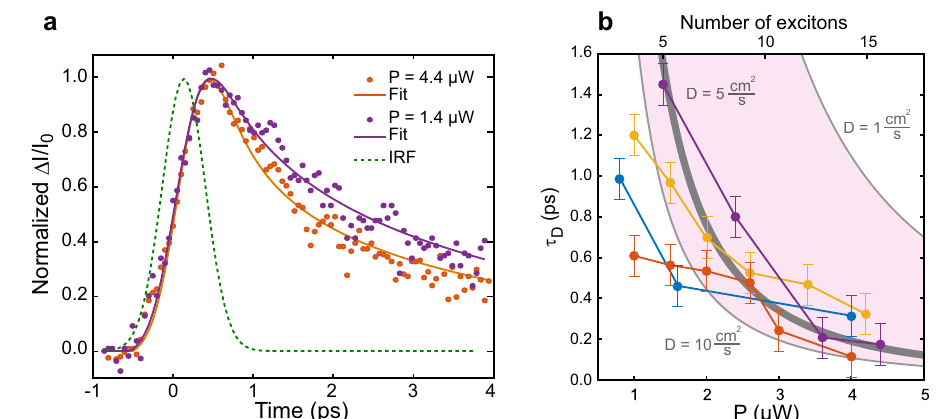
Fig. 3 | Ultrafast exciton-exciton annihilation in single SWCNTs. a Pump-probe transientdetected forasingle(6,5)SWCNTforpump powersof 4.4 μ Wand1.4 μ W together with the corresponding fi tted model curves, respectively. b Pump power